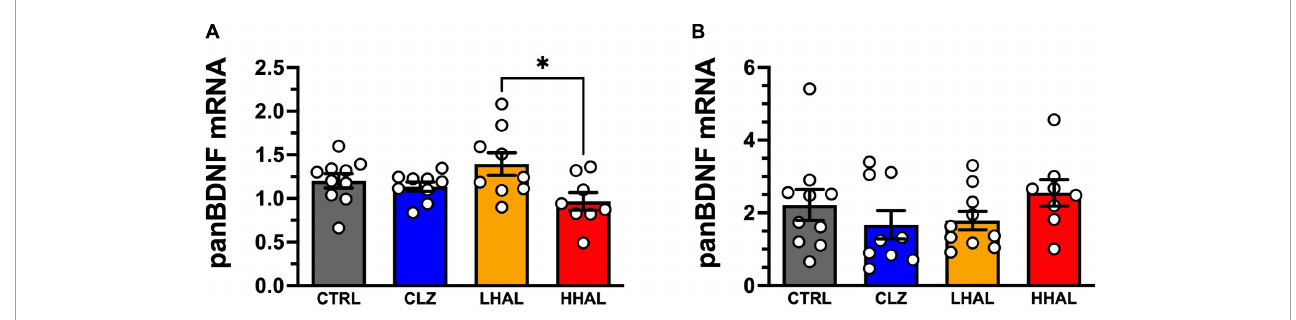
FIGURE1 panBDNF mRNA levels in the DLPFC and EC of rhesus monkeys following 6-month antipsychotic administration regimen. Chronic antipsychotic administration resulted in a significant change in pan BDNF mRNA expression in the DLPFC [ F ( 3 , 32 ) = 3.321, P = 0.0320] (A) . Post hoc analysis revealed a significant difference between the groups was LHAL > HHAL ( P = 0.0197); however, none of the groups were significantly different from CTRL. In the EC, no significant differences in panBDNF expression were detected following chronic antipsychotic administration [ F ( 3 , 33 ) = 1.163, P = 0.3385] in the EC (B) . pan BDNF expression values are presented as bars which represent the mean ( ± S.E.M.) values following determination from relative standard curves. For each subject, expression values were calculated as quantitative mean value of pan BDNF divided by the average of the quantitative mean values for the two reference genes for the respective regions. Bars represent the mean ± S.E.M. for the respective groups. Circles denote expression levels for individual subjects per group. ∗ p < 0.05.